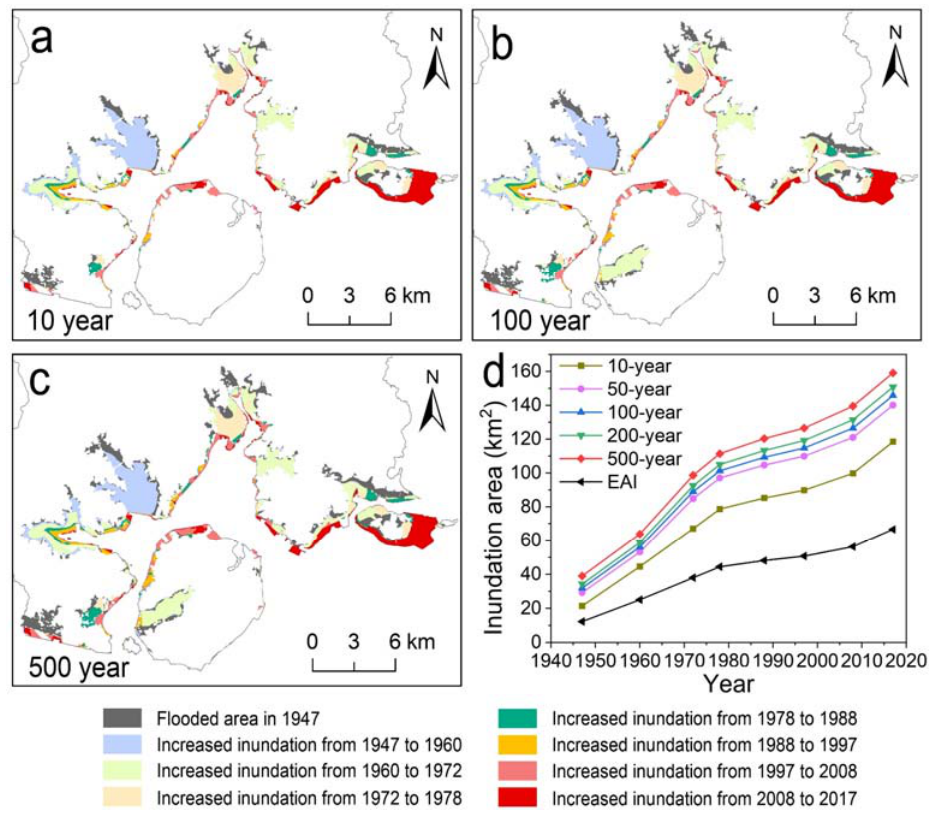
Figure 7. Spatial distribution and statistics of coastal flooded area at different return periods. ( a ) Coastal flooded area of a 10-year storm tide event, ( b ) coastal flooded area of a 100-year storm tide event, ( c ) coastal flooded area of a 500-year storm tide event, and ( d ) statistical results of coastal flooded area.